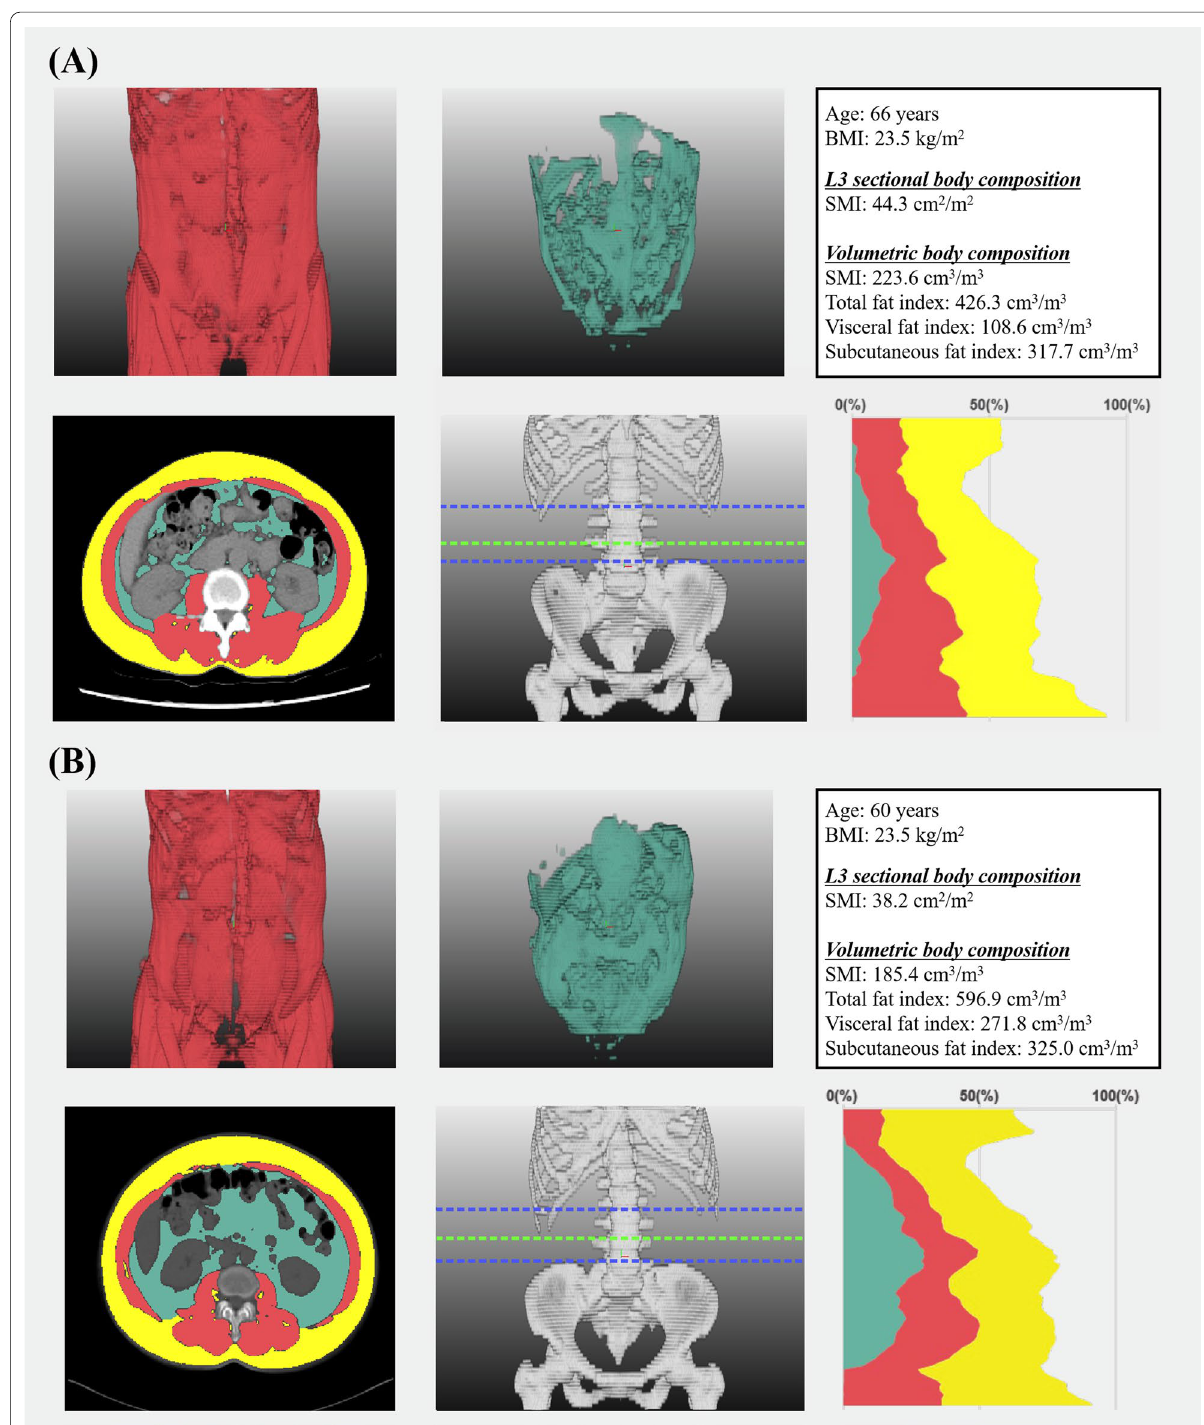
Fig. 1 Evaluation of body composition using CT image. Despite similar baseline BMI, two patients showed different body composition profiles as follows: A a 66‑year‑old, non‑sarcopenic woman with high‑volumetric SMI; B a 60‑year‑old, sarcopenic woman with low‑volumetric SMI. Red, skeletal muscle; green, abdominal visceral fat; yellow, subcutaneous fat; blue lines indicate the waist; light green line indicates L3 level. L3 level cross‑sectional images are also